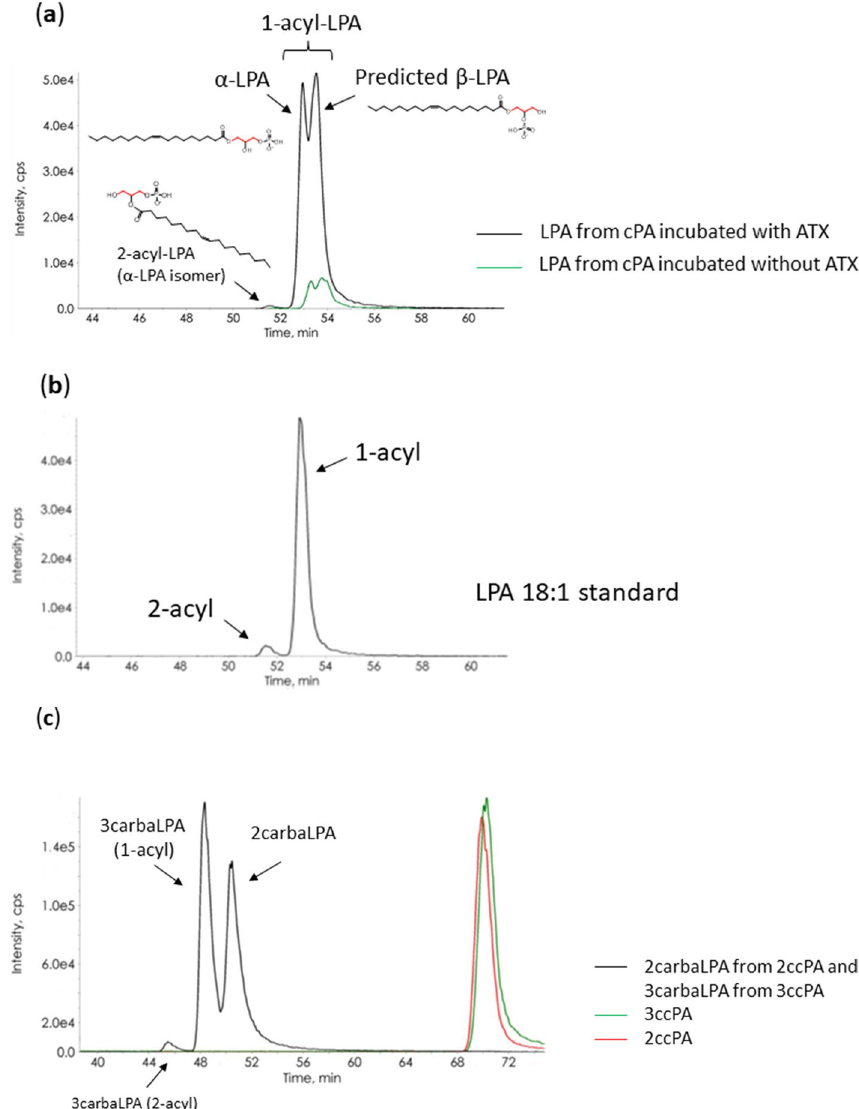
Figure 7. Chromatogram of ( a ) lysophosphatidic acid (LPA) 18:1 produced from cyclic phosphatidic acid (cPA) 18:1, ( b ) standard LPA 18:1 shown for comparison, and ( c ) 2-carba-lysophosphatidic acid (2carbaLPA) and 3-carba-lysophosphatidic acid (3carbaLPA) produced from 2-carba-cyclic phosphatidic acid (2ccPA) and 3-carba-cyclic phosphatidic acid (3ccPA), respectively, after analysis via liquid chromatography coupled to triple quadrupole mass spectrometry (LC-QqQ). The simplified chemical structure of α-LPA (1-acyl), α-LPA isomer (2-acyl), and predicted β-LPA are shown. ( a ) cPA 18:1 (final concentration: 10 μM) and ( c ) 2ccPA 18:1 plus 3ccPA 18:1 mixture (final concentration: 10 μM each) as substrates were incubated, with or without ( a only) human recombinant autotaxin (ATX, final concentration: 50 nM), for 2 h at 37 °C. LC-QqQ conditions are described in the “Materials and methods”